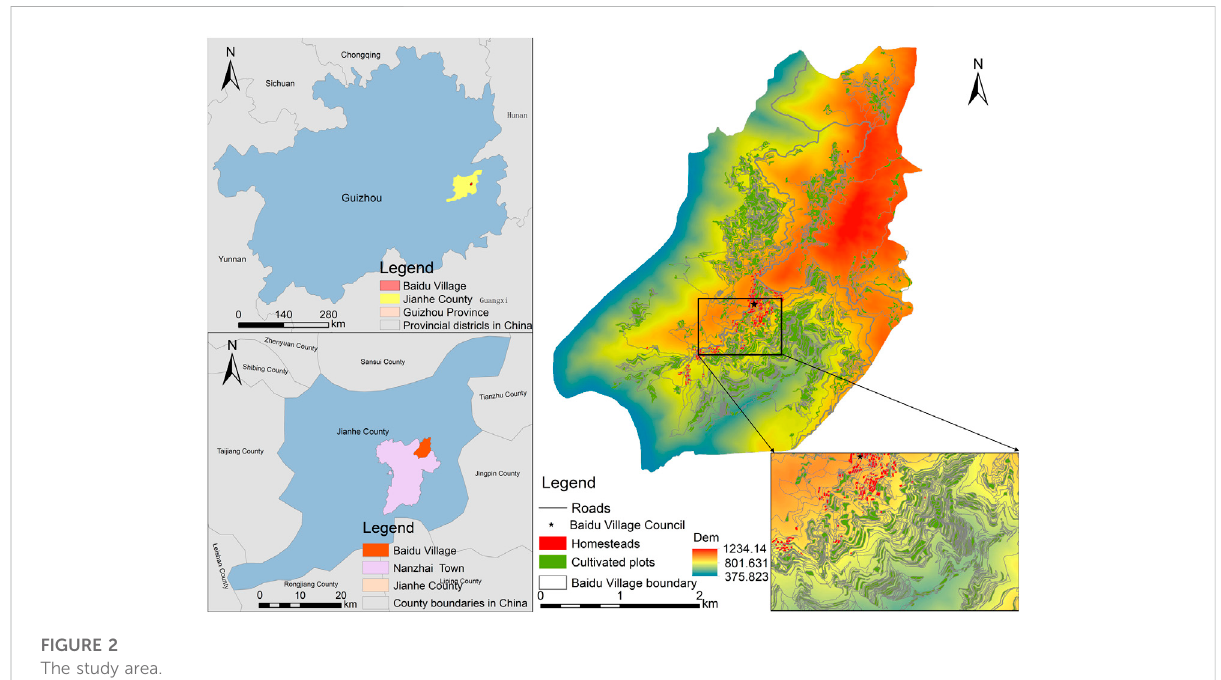
FIGURE 2 The study